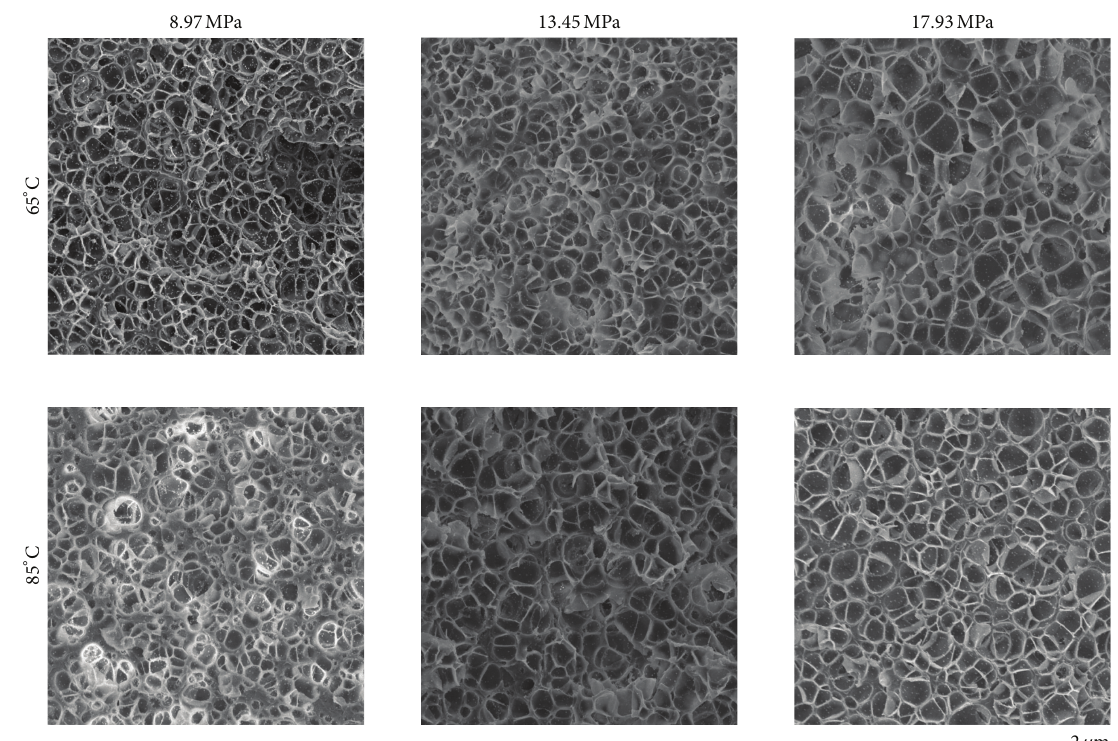
Figure 7: SEM images of the foamed highly fluorinated, high concentration (FF-High) sample at various pressures and temperatures.